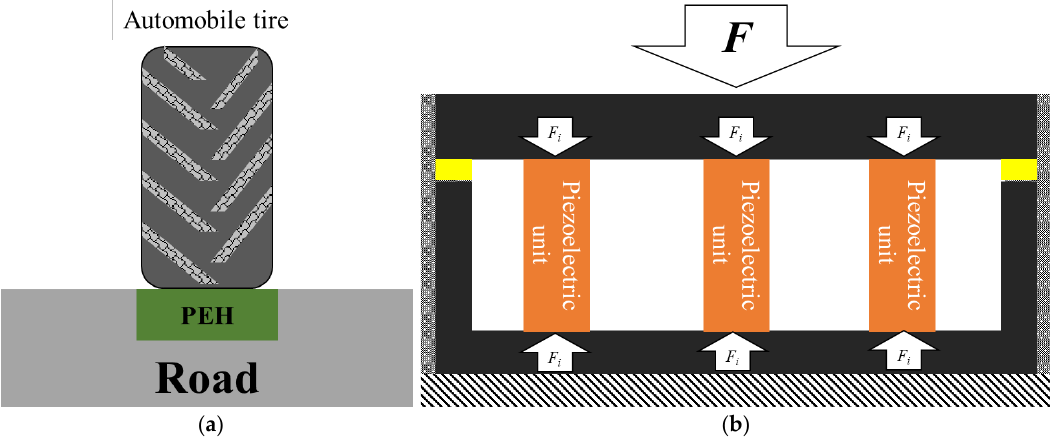
Figure 1. PEH road. ( a ) Schematic of PEH road; ( b ) schematic of internal force of the PEH.